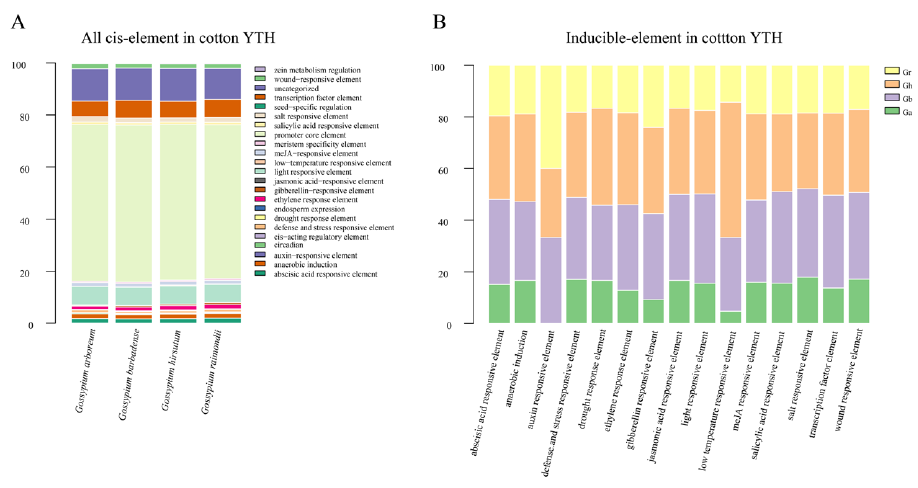
Figure 5. Cis -element analysis of YTH genes in 4 cotton species. ( A ) Cis -elements in the promoters of YTHs . ( B ) Inducible elements in the promoters of YTHs .